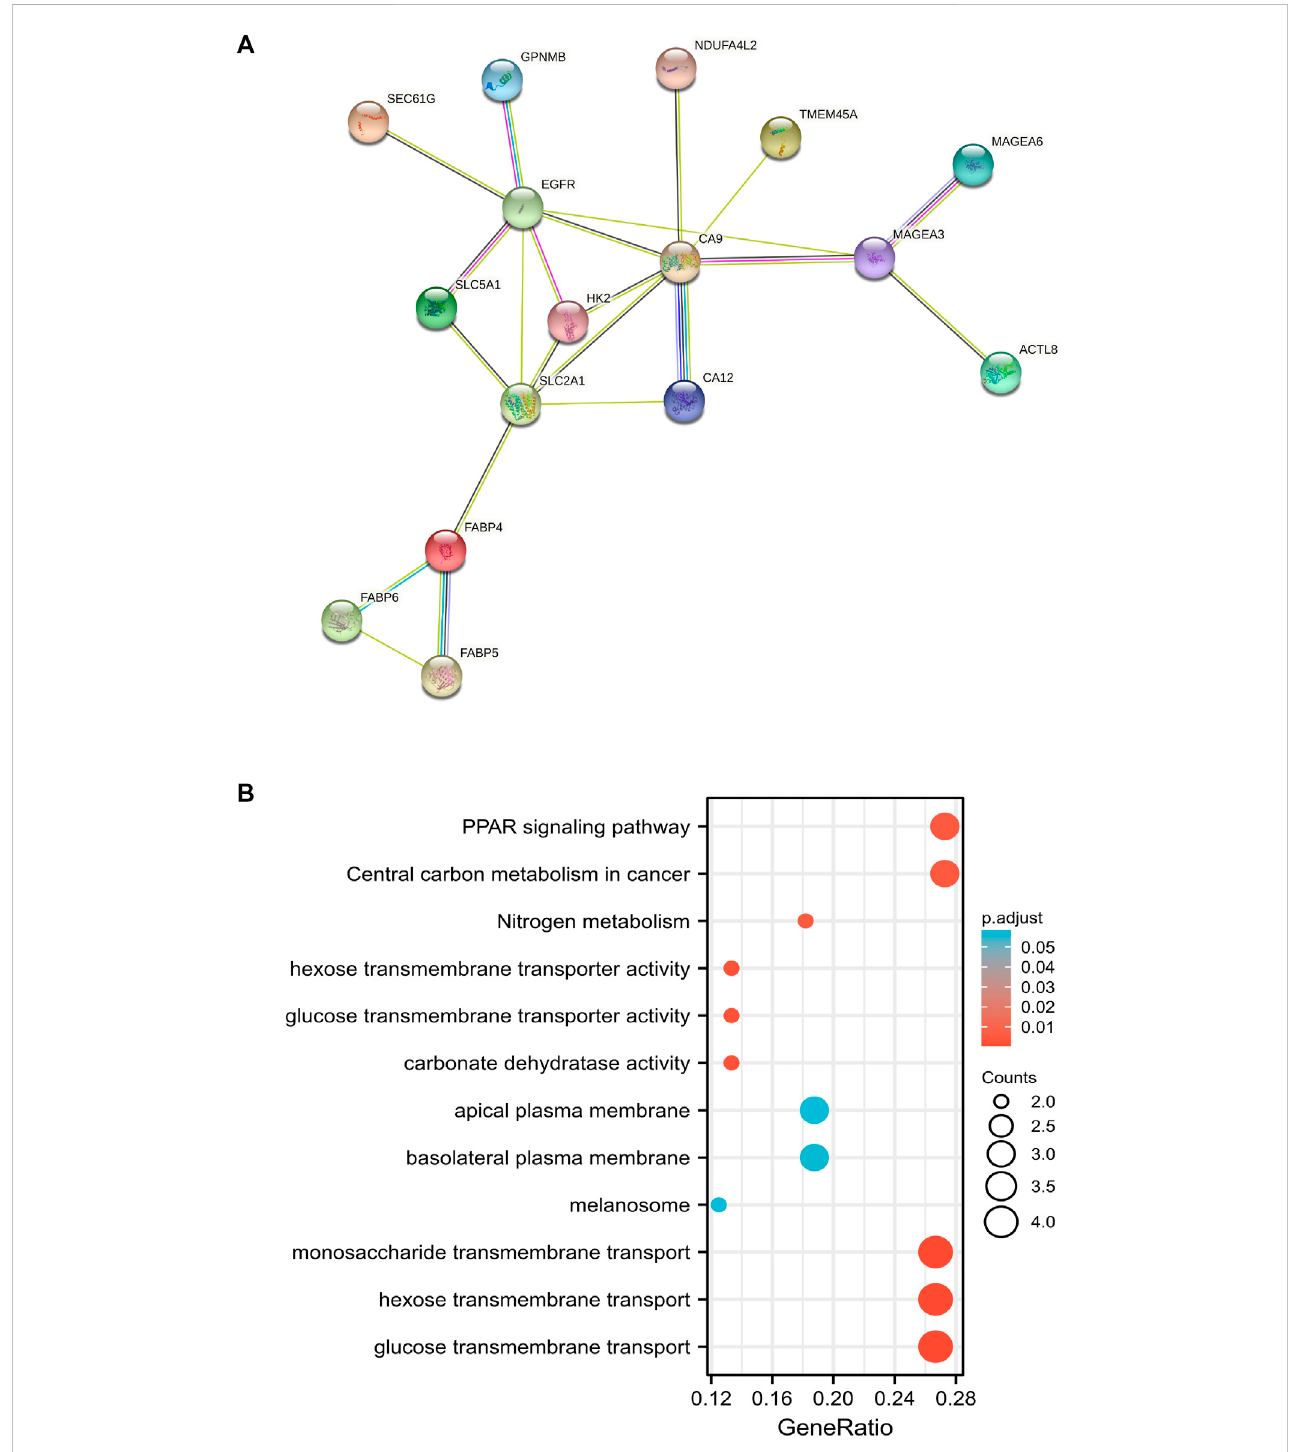
FIGURE 4 The protein association network related to up-regulated genes in chemotherapy-sensitive group. (A) Sixteen proteins among 60 up-regulated proteins in sensitive group which had functional and physical associations were predicted by STRING web platform. (B) GO and KEGG analyses of 16 related genes in functional protein association